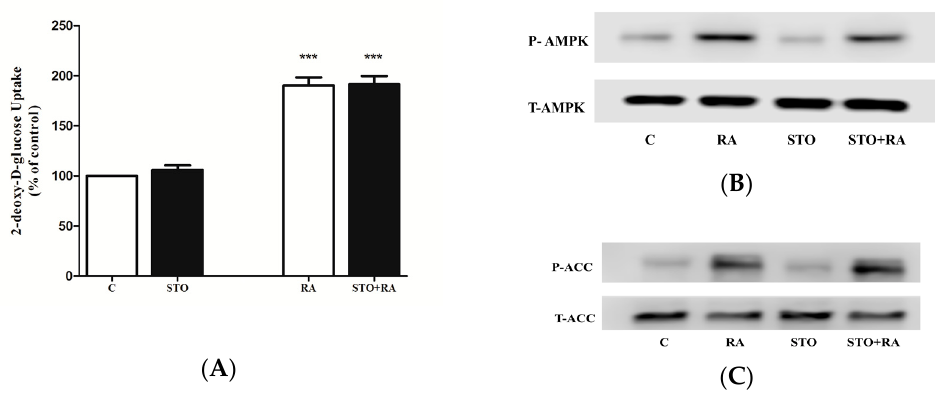
Figure 5. ( A ) Effect of STO-609 on rosmarinic acid (RA)-induced glucose transport. L6 myotubes were incubated in the absence (control, C) or presence of 27 µM STO-609 (STO) for 1 hour followed by the addition of 5.0 µM RA (4 h) and glucose uptake measurements. Results are the mean ± SE of 3 independent experiments. *** p < 0.001 vs. control. ( B ) Effect of STO-609 (STO) on AMPK and ( C ) ACC phosphorylation. Whole-cell lysates were immunoblotted for phospho (Thr 172) (P-AMPK) or total AMPK (T-AMPK) ( B ) or for phospho (Ser 79) (P-ACC) or total ACC (T-ACC) ( C